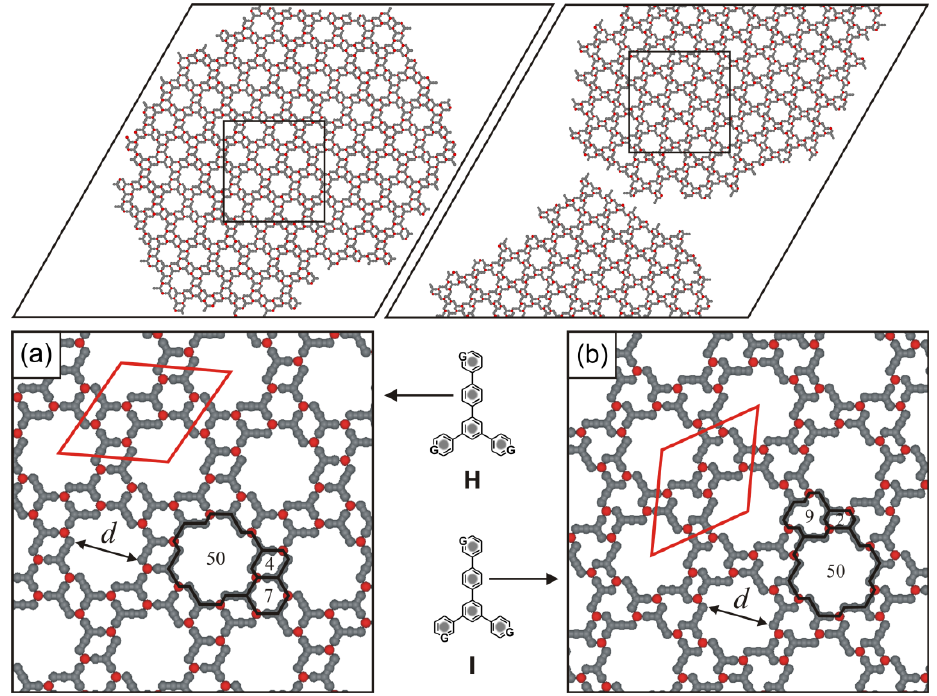
Figure 9. ( a ) A crystalline multiporous superstructure comprising 600 metal atoms and 600 ligands H in a 1:1 stoichiometric ratio; ( b ) openwork metal–organic phase composed of 600 metal atoms and 600 ligands I in a 1:1 stoichiometric ratio. In the magnified fragments of the ordered metal–organic arrays, the rhombic unit cells are marked (solid red lines). The solid black lines delimit the edges of empty nanopores differing in size and shape. Inside the highlighted nanopores, the numbers of empty adsorption sites are given. For the largest gear-like shaped nanopores, their diameters d (corner-to-corner) are marked.